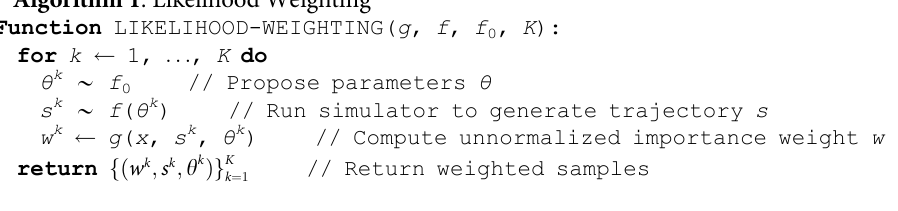
Algorithm 1 : Likelihood